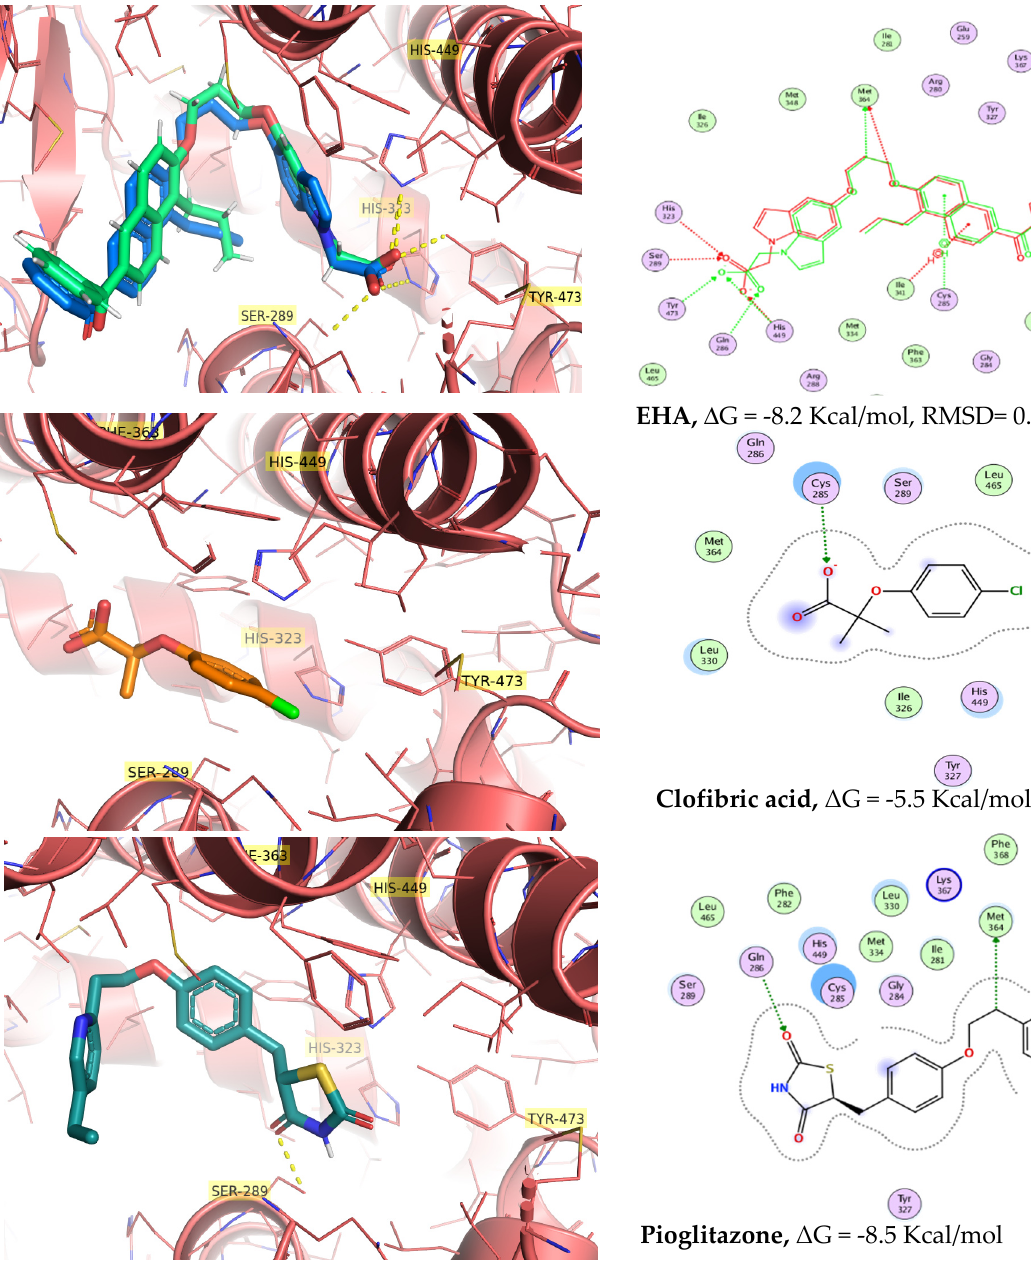
Figure 5. Three-dimensional pose of co-crystal structure reference of 2F4B (PPAR γ )/EHA (carbon atoms colored blue, X-ray; and green, redocked pose). Docked pose of clofibric acid (carbon atoms colored orange), pioglitazone (carbon atoms colored cyan), and its 2D diagram of interaction. (In the case of EHA, the 2D overlay complexes are displayed in green for the co-crystal X-ray representation and red for the re-docked pose.)